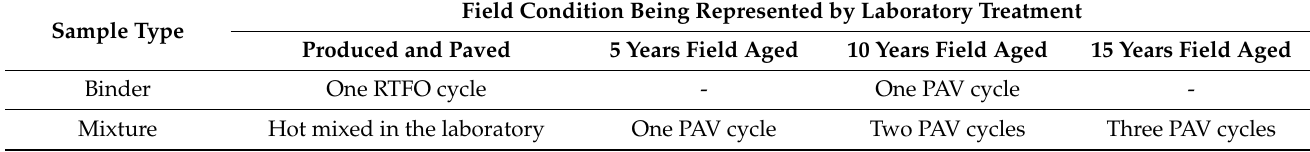
Table 1. Accelerated ageing